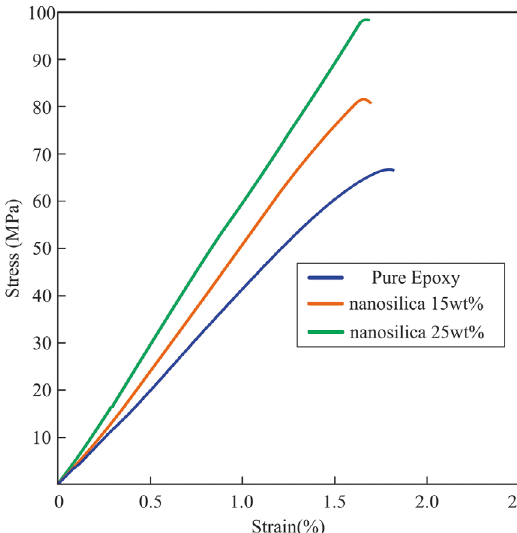
Figure 3. Typical tensile stress-strain curves of nanosilica-modified SP115 compared to the neat epoxy. An optical (confocal) 3D measurement system µsurf by Nanofocus was used to capture in detail the fracture surface of the tensile test samples. Figure 5 shown the 2D profiles of the neat epoxy and 25%wt nanosilica fractured